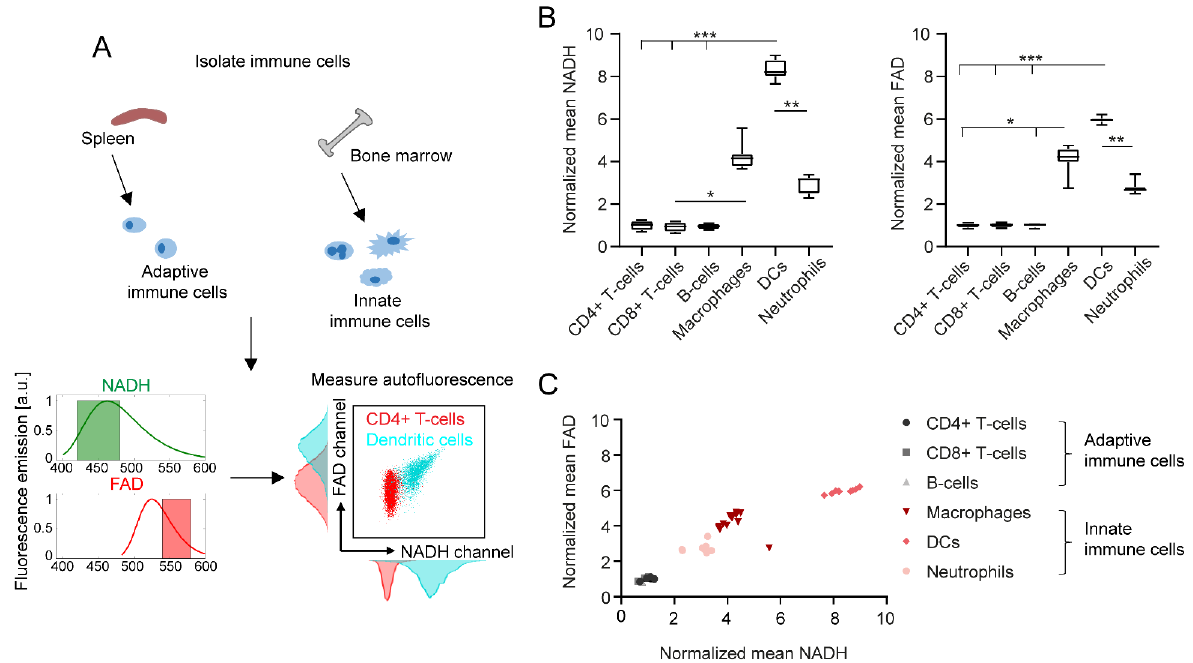
Figure 1. Immune cell subtypes can be differentiated by NADH and FAD autofluorescence signals in flow cytometry. ( A ) Schematic representation of immune cell isolation from murine spleen and bone marrow, and exemplary autofluorescence analysis in flow cytometry. ( B ) NADH and FAD signal mean values of different immune cell subtypes, normalized to the mean values of alive, unstimulated CD4+ T cells. For statistical analysis, a Kruskal – Wallis test with subsequent Dunn’s multiple comparisons test was used (* p < 0.05, ** p < 0.01, *** p < 0.001). At least four samples per group were analysed. Each sample reflects either cells isolated from one mouse (CD4+ T cells, CD8+ T cells, B cells, neutrophils) or cells cultured in one culture dish (macrophages, dendritic cells). ( C ) Comparison of normalized mean NADH and FAD signals in different immune cell types.